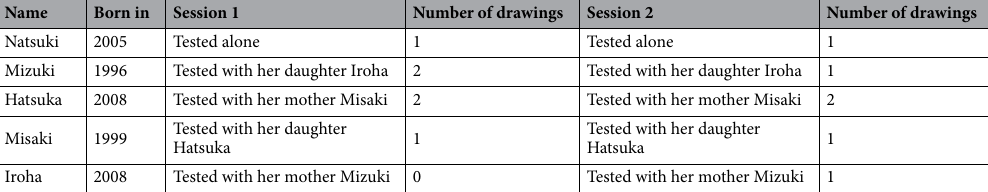
Table 2. Name and year of birth for each chimpanzee and the number of drawings completed for each test session.